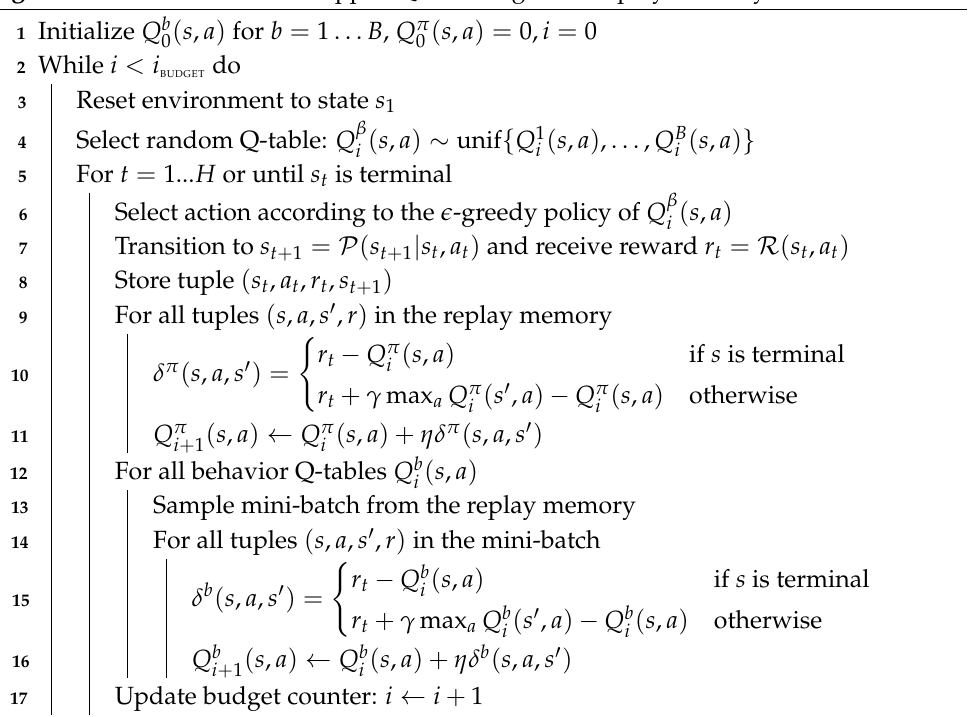
Algorithm A6: Tabular Bootstrapped Q-Learning with Replay